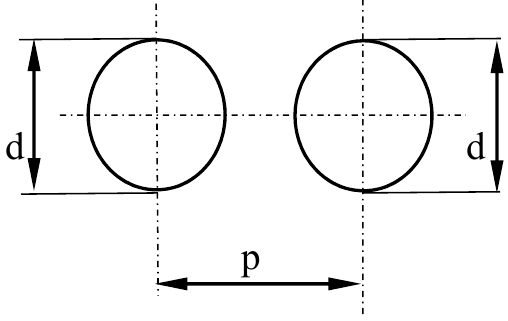
Figure 4. Reference scheme.